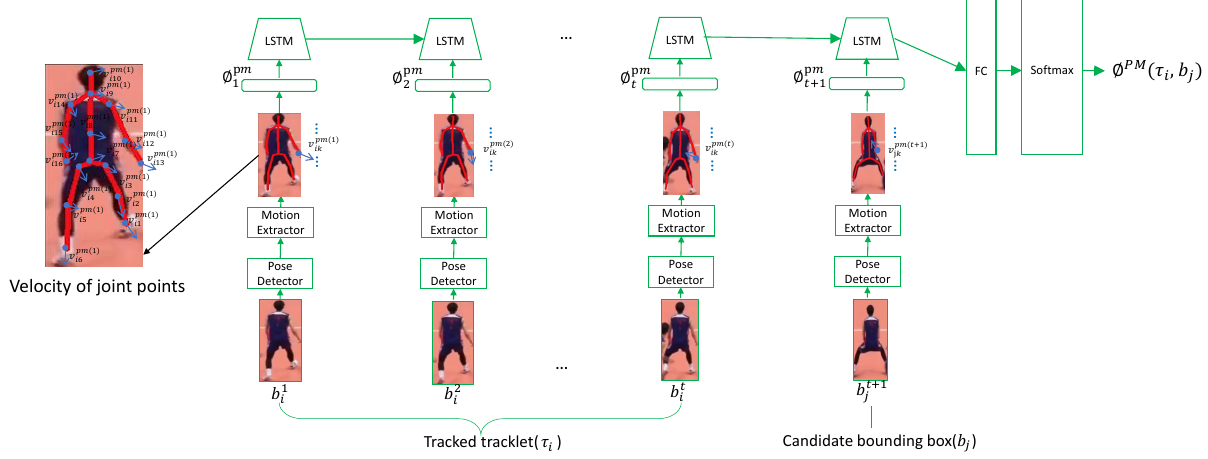
Figure 3. The architecture of Pose-based Motion Stream (PMS). The inputs are τ and b j . τ is tracklet of i th athlete, composed of his bounding boxes from time 1 to t, and b j is a candidate detection at time t + 1. The motion features are fed into an Long Short-Term Memory (LSTM) followed by a softmax layer to generate the similarity score φ PM ( τ i , b j ) . Velocity definition of body joints can be seen in